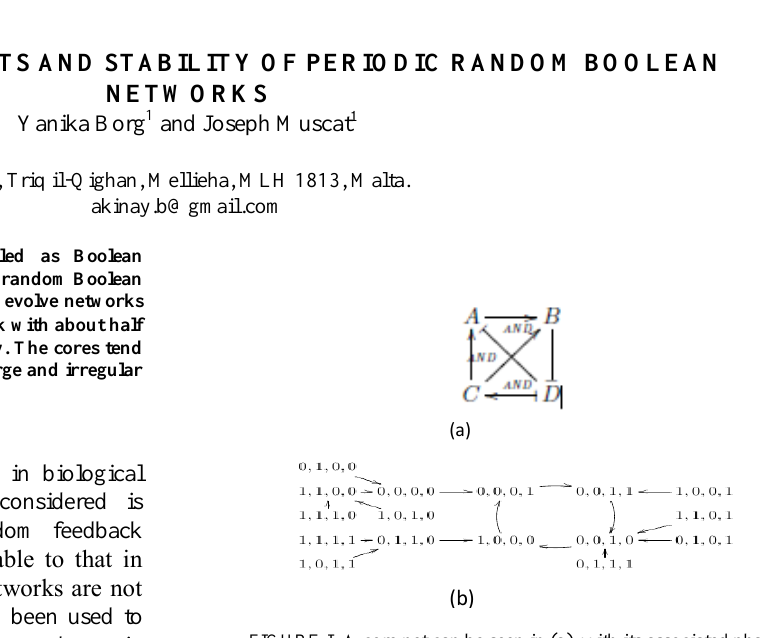
FIGURE I: A core net can be seen in (a), with its associated phase diagram in (b), which has only one attractor